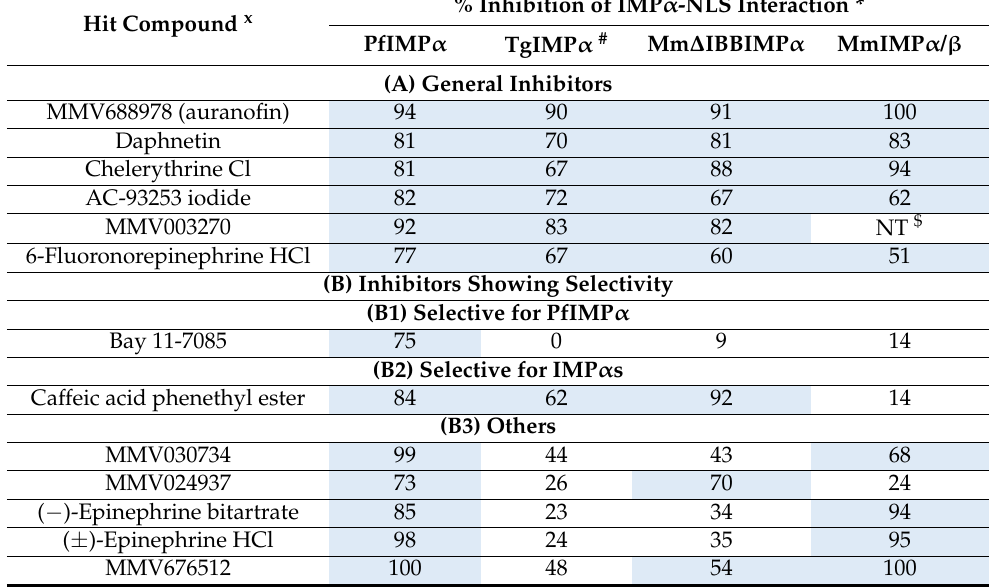
Table 1. Selectivity of PfIMP α